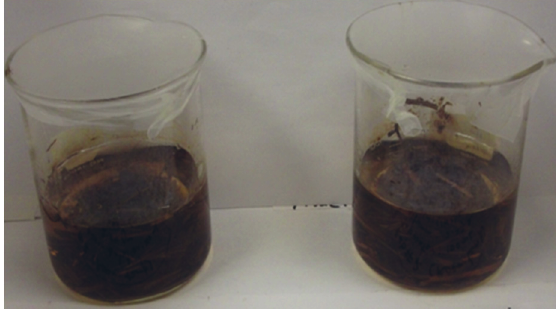
Figure 7. Bitumen samples with charred hay (60 min) added in deionized water ( right ) and Instant Ocean solution ( left ) at room temperature (23 °C) and time = 186